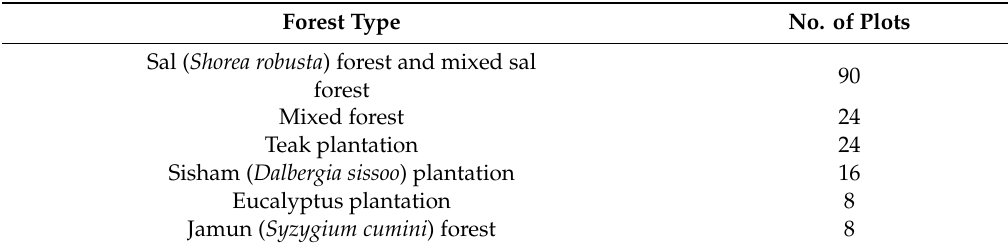
Table 1. Number of field plots for each forest